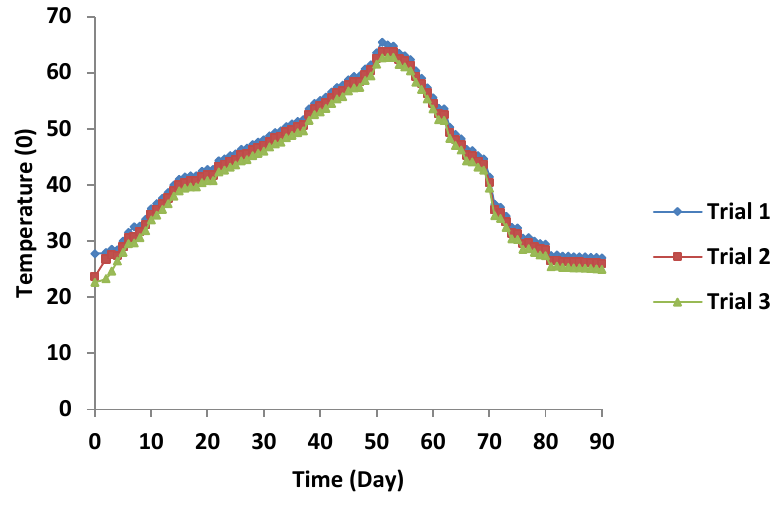
Fig. 3 Variation of the temperature of the three trials during composting Moisture